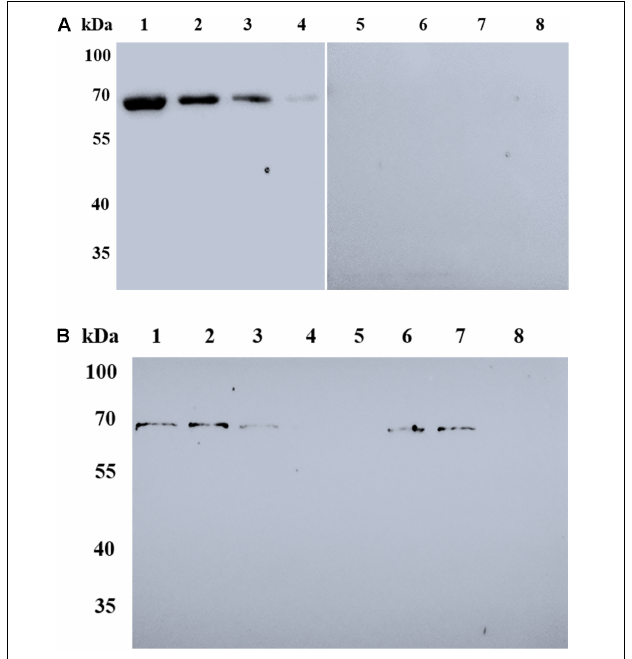
FIGURE 5 | Western blot analysis of RBC binding to rBmSA1. (A) Lanes 1–4: mouse RBC binding to rBmSA1 at concentrations of 2.0, 1.0, 0.5, and 0.25 mg/mL, respectively; Lanes 5–8: mouse RBC binding to GST (Negative control) with the same concentrations of rBmSA1. All lanes were reacted with anti-GST antibodies. (B) Lane 1: mouse RBC binding to rBmSA1 at concentrations of 0.1 mg/mL; Lanes 2–5: mouse RBC binding to rBmSA1 at concentrations of 0.1 mg/mL with 50, 100, 250, and 500 µ g/mL purified anti-BmSA1 antibody, respectively; Lane 6: mouse RBC binding to rBmSA1 at concentrations of 0.1 mg/mL with 500 µ g/mL purified mouse pre-immune serum; Lane 7: mouse RBC binding to rBmSA1 at concentrations of 0.1 mg/mL with 500 µ g/mL purified anti-GST antibody; Lane 8: mouse RBC.